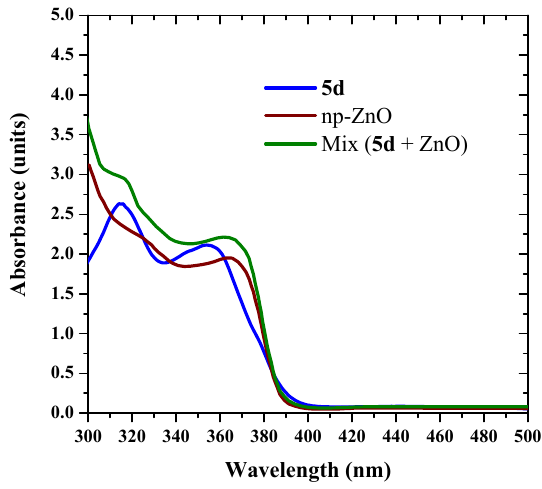
Figure 6. The absorption spectra of 5d , ZnO and the mix solution in toluene. Both ZnO and compound 5d pure did not produce any laser action for any given pump energies at 355 nm, but they did produce laser-induced fluorescence (LIF). On the other hand, the mixed solution was active for high-energy optical pumping produced reasonable LIF. When the pump energy was below 15 ± 1 mJ, the mixture produced LIF without sharp peaks.